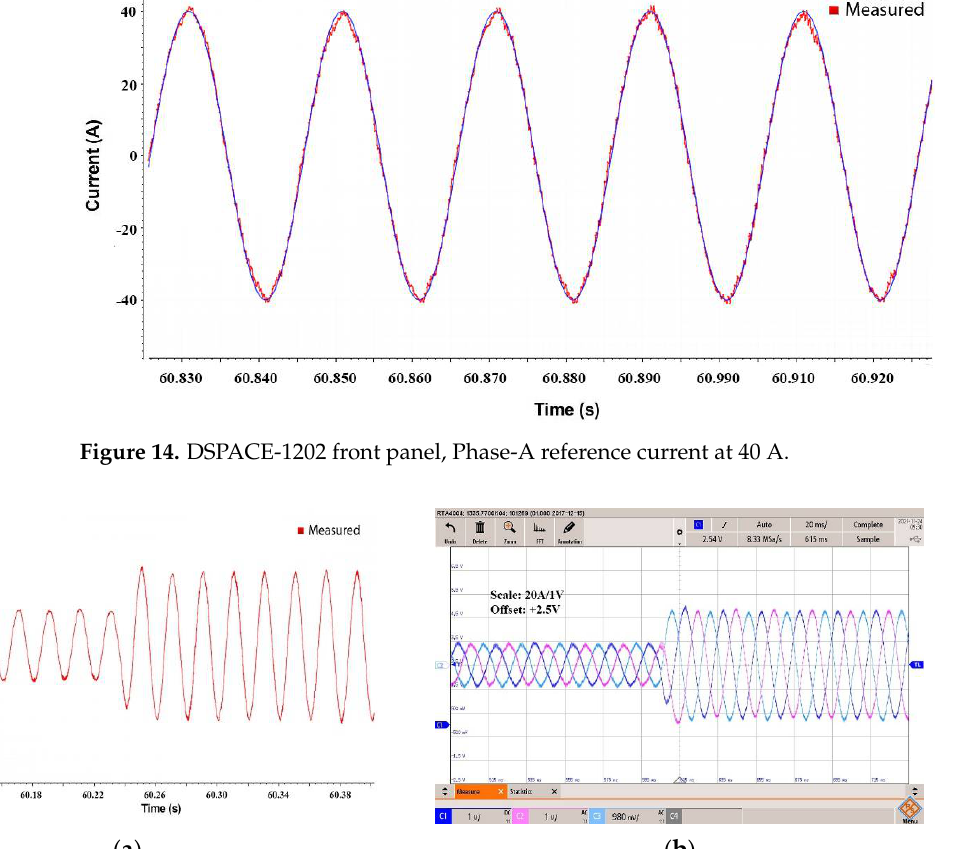
Figure 15. Current step response from 20 A to 40 A: ( a ) DSPACE-1202 front panel; ( b ) RTA-4004 oscilloscope output.